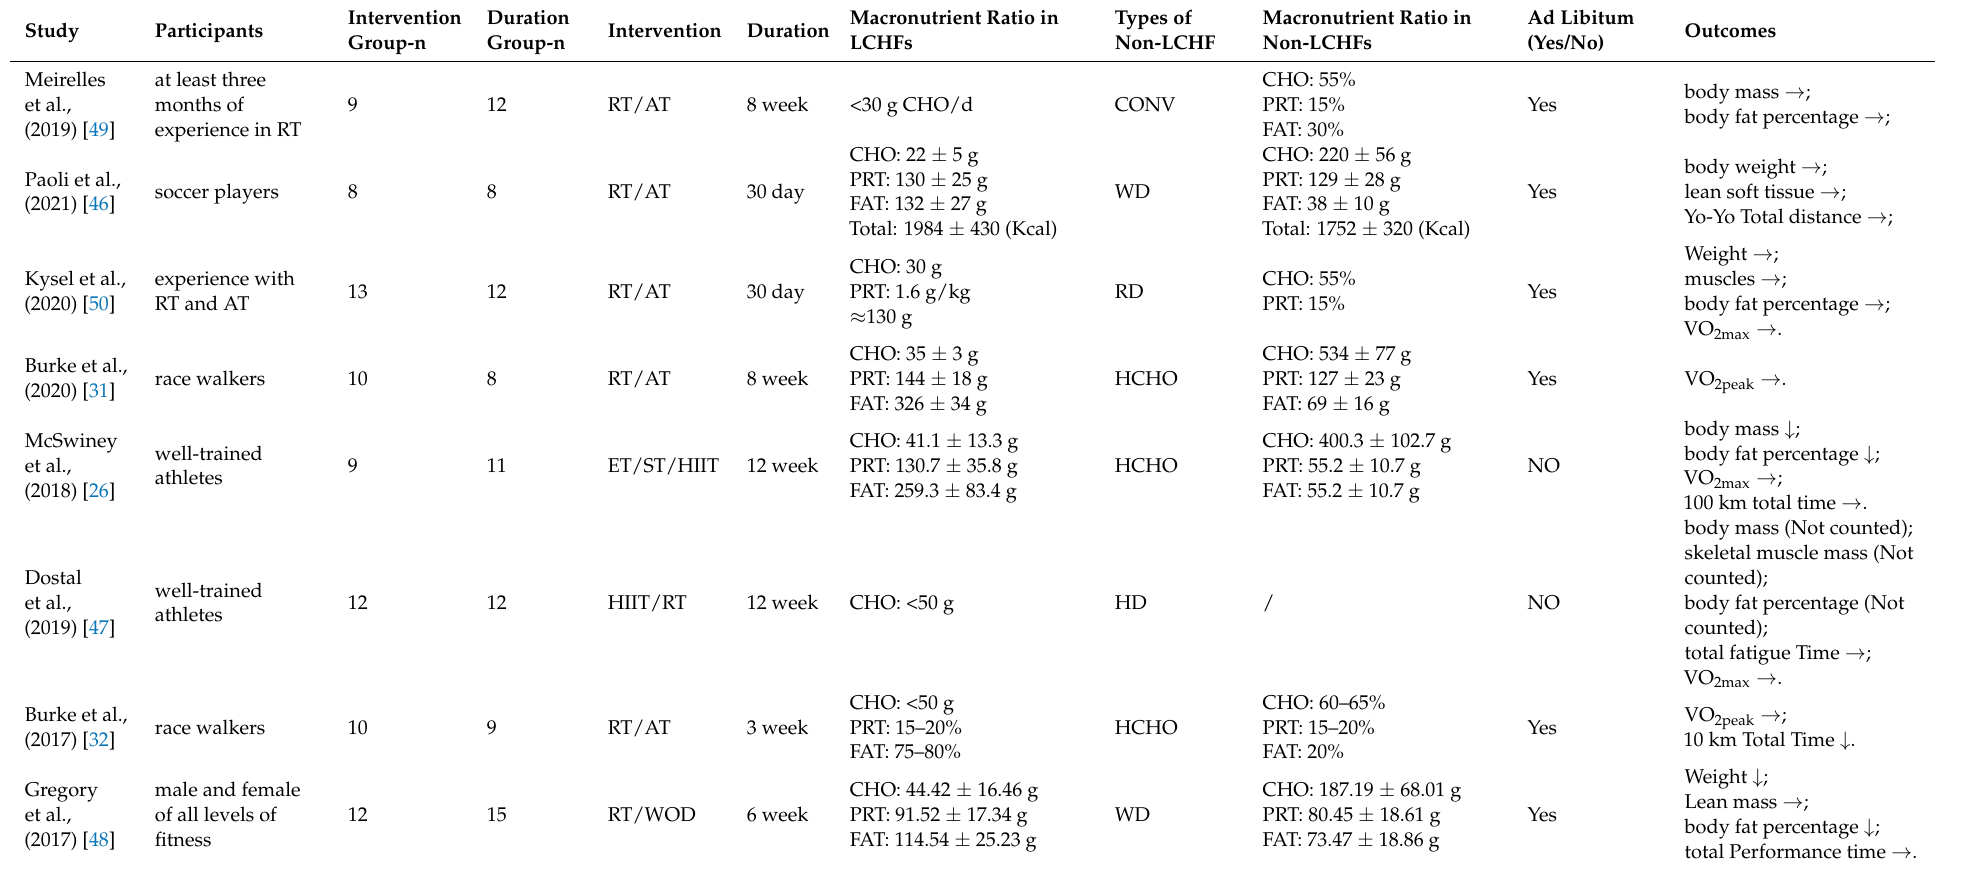
Table 1. Characteristics of the eight included